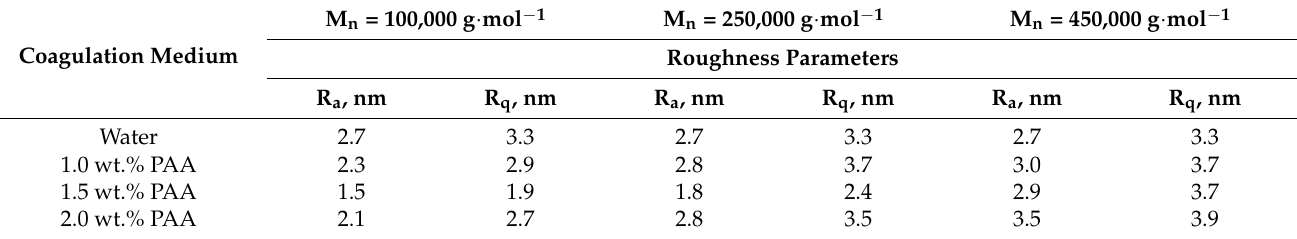
Figure 5. AFM images of the membrane skin layers: ( a ) PA ‐ 0; ( b ) PA ‐ 100 ‐ 1.0; ( c ) PA ‐ 250 ‐ 1.0; ( d ) PA ‐ 450 ‐ 1.0; ( e ) PA ‐ 100 ‐ 1.5; ( f ) PA ‐ 250 ‐ 1.5; ( g ) PA ‐ 450 ‐ 1.5; ( h ) PA ‐ 100 ‐ 2.0; ( i ) PA ‐ 250 ‐ 2.0; and ( j ) PA ‐ 450 ‐ 2.0. Table 2. Surface roughness parameters of the membrane skin layers.